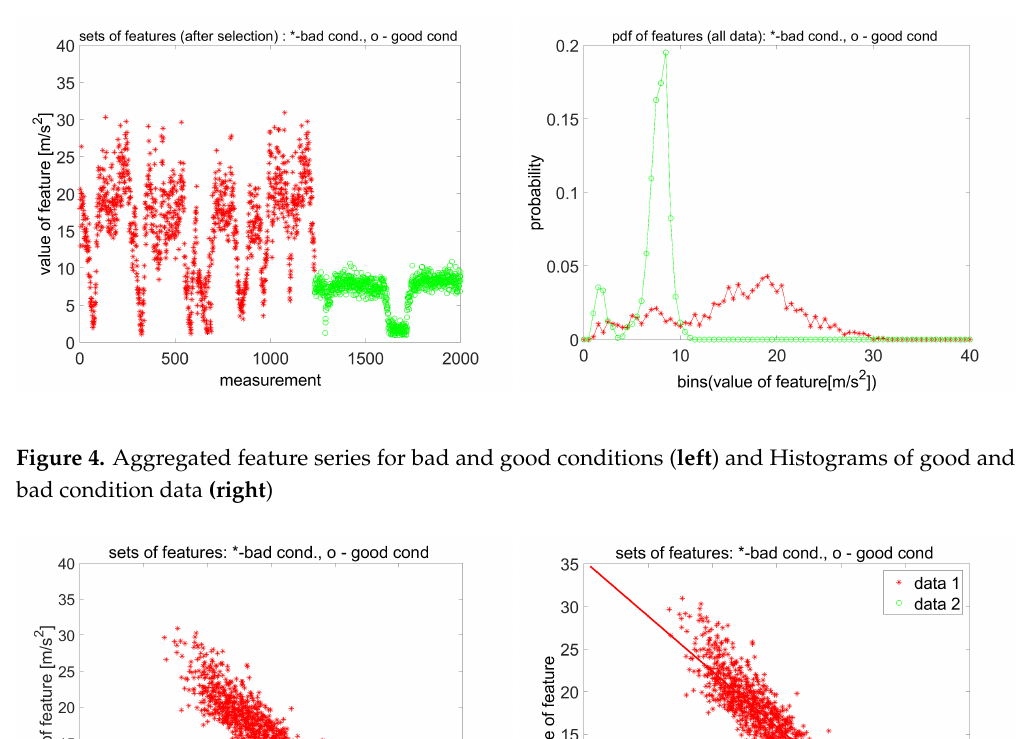
Figure 3. Examples of the spectra (results of spectral analysis)—( left ): bad condition data, ( right ): good condition data.